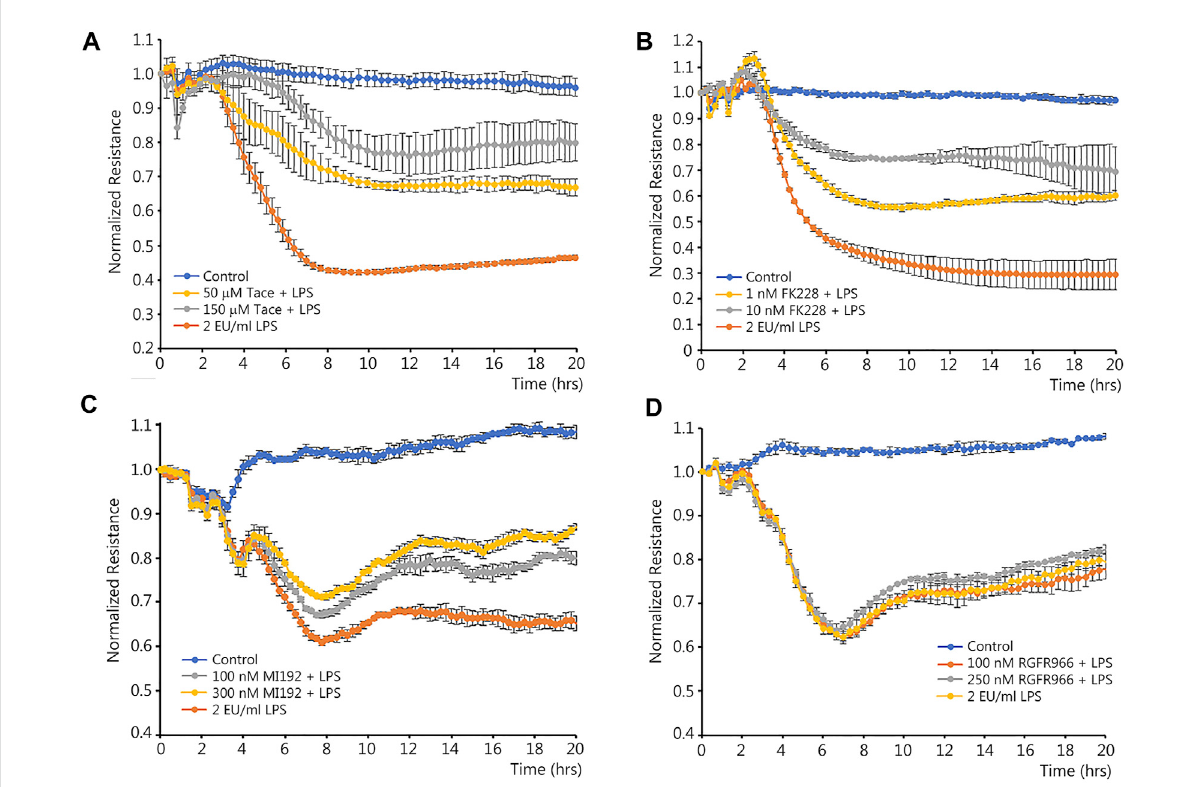
FIGURE 1 Effects of class I HDACs selective inhibitors on LPS-induced endothelial barrier disruption in cultured human lung microvascular endothelial cells. HLMVEC monolayers grown in ECIS arrays were pre-treated with HDAC inhibitors or vehicle for 30 min then challenged with LPS. TER was recorded in real time to evaluate possible barrier-protective effects of HDAC inhibitors. Data are shown for tacedinaline (HDAC -1 and -3 inhibitor) (A) ,FK228(HDAC-1and-2inhibitor) (B) ,MI192(HDAC-2and-3inhibitor) (C) ,andRGFP966(HDAC3inhibitor) (D) .Dataaremean±SEM, n =4. * p < 0.05 vs . Control; † p < 0.05 vs . LPS